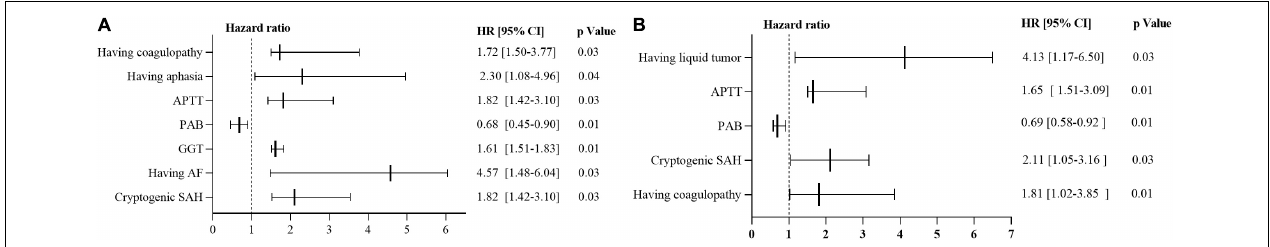
FIGURE 6 | Predictors of mortality via Cox regression models. (A) Predictors of 30-day mortality via Cox regression models. (B) Predictors of 90-day mortality via Cox regression models. HR > 1 implies unfavorable prognosis for SAH in patients with active cancer. HR of 1 corresponds to no effect. HR, hazard ratio; 95% CI = 95% confidence interval; SAH, subarachnoid hemorrhage; APTT, activated partial thromboplastin time; PAB, prealbumin; GGT, gamma-glutamyl transferase; AF, Atrial fibrillation.